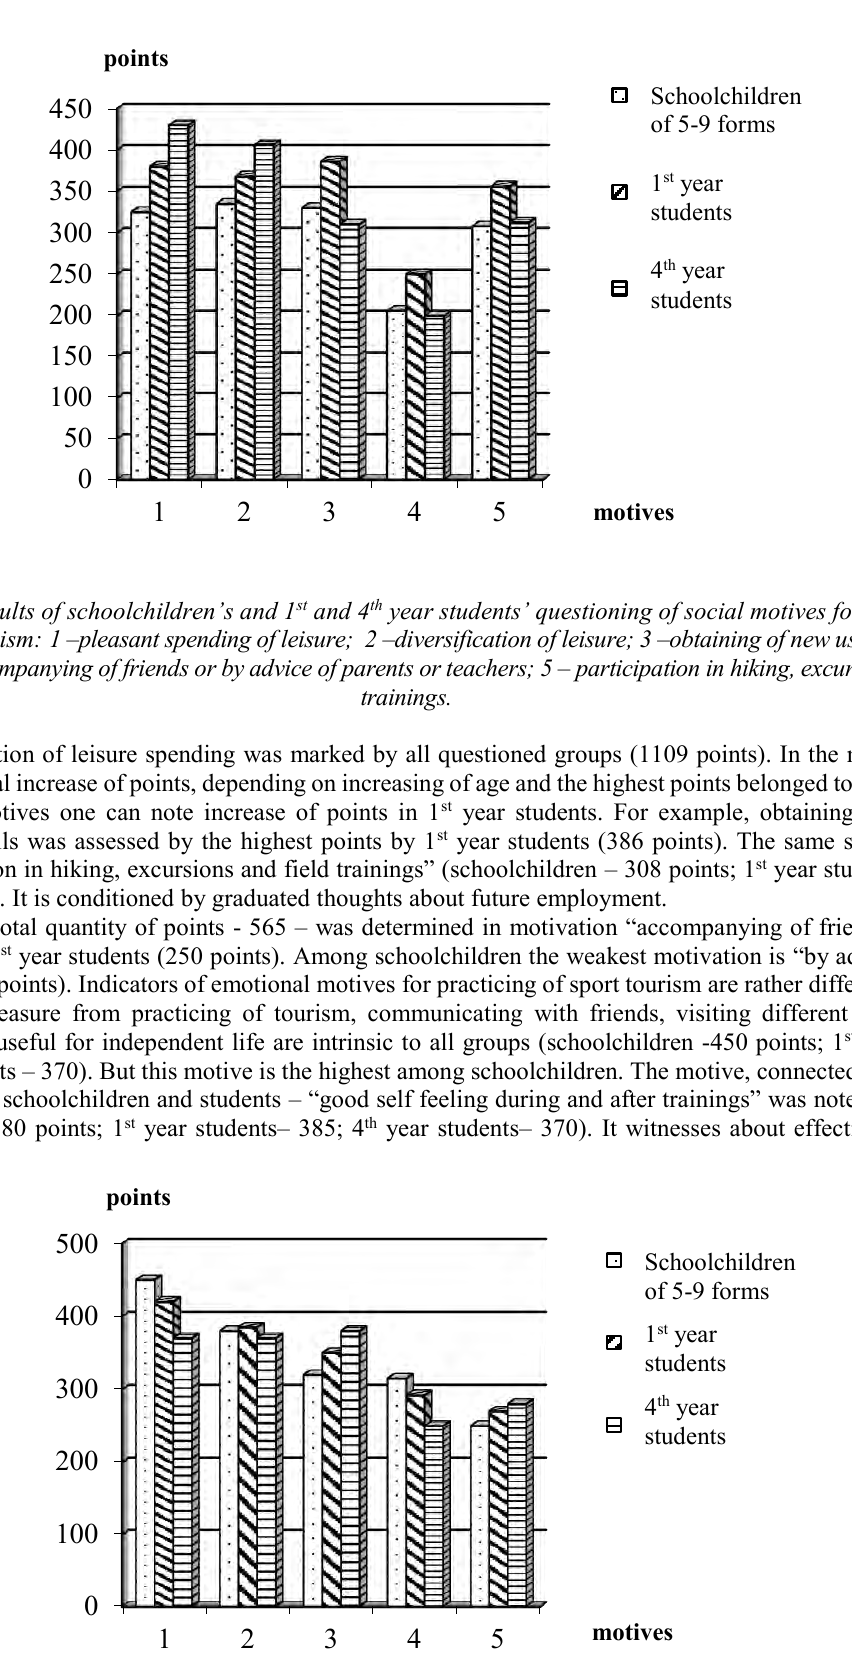
Fig.3. Results of schoolchildren’s and 1 st and 4 th year students’ questioning of emotional motives for of self estimation and self confidence; 4 –wish to cultivate courage and resoluteness; 5 – wish to have good body constitution and trained